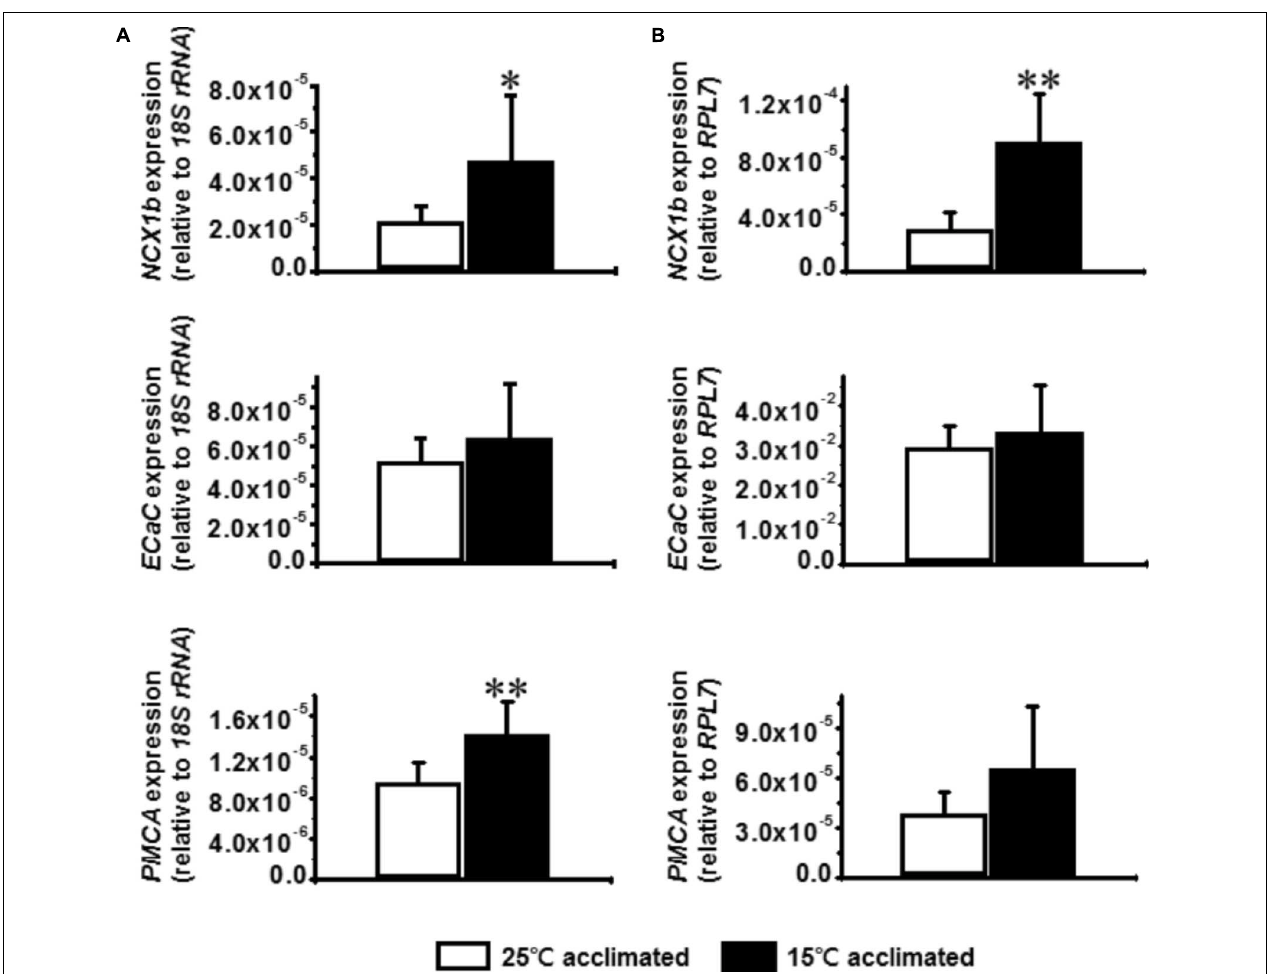
FIGURE 5 | Effect of cold acclimation on the expression of calcium transporters in tilapia or goldfish gill. Relative mRNA expression of Na + /Ca 2 + exchanger 1b ( NCX1b ), epithelial Ca 2 + channel ( ECaC ), plasma membrane Ca 2 + ATPase ( PMCA ) in (A) goldfish or (B) tilapia gill were measured by real-time quantitative PCR. The expression of 18S ribosomal RNA ( 18S rRNA ) was used as an internal control for goldfish and ribosomal protein L7 ( RPL7 ) was used for tilapia. Student’s t -test, ∗ p ≤ 0.05, ∗∗ p ≤ 0.01 compared to 15 ◦ C acclimated fish. n = 6 per group.